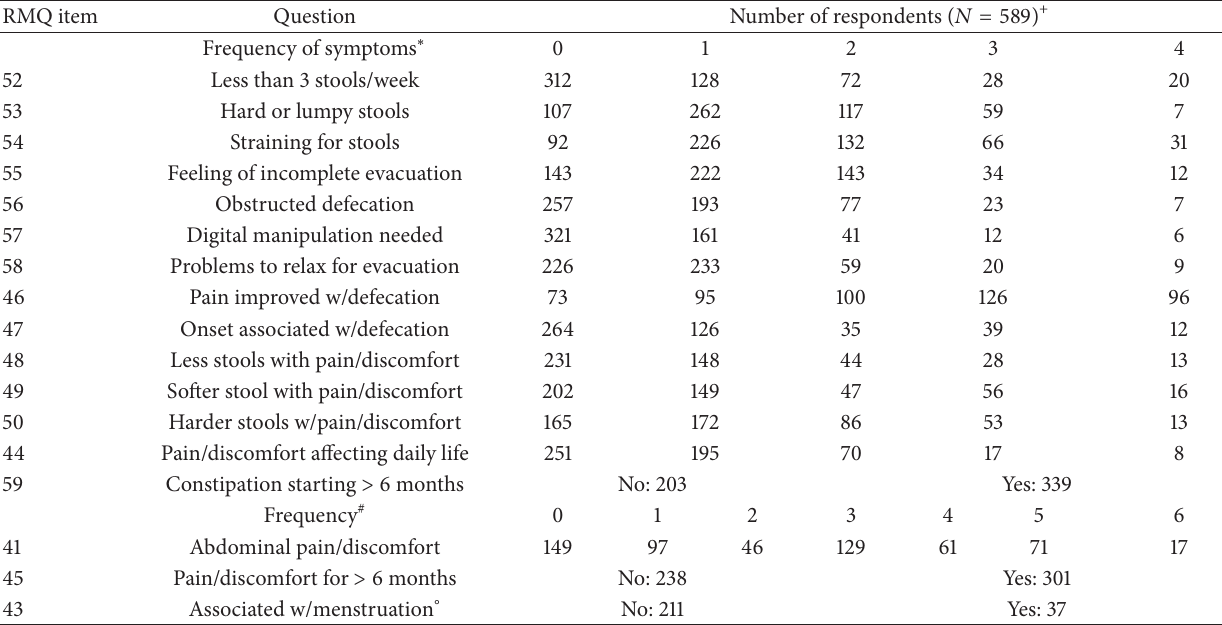
Table 2: IBS and constipation symptoms according to the Rome Modular Questionnaire (RMQ) (validated German version). Absolute number of respondents is given. Please note that the sequence of questions was different than in the RMQ because all participants were asked for their constipation symptoms first (52–58, 59), followed by the abdominal pain/discomfort questions (41, 45, 43, 46–50, and 44). Data are unweighted.